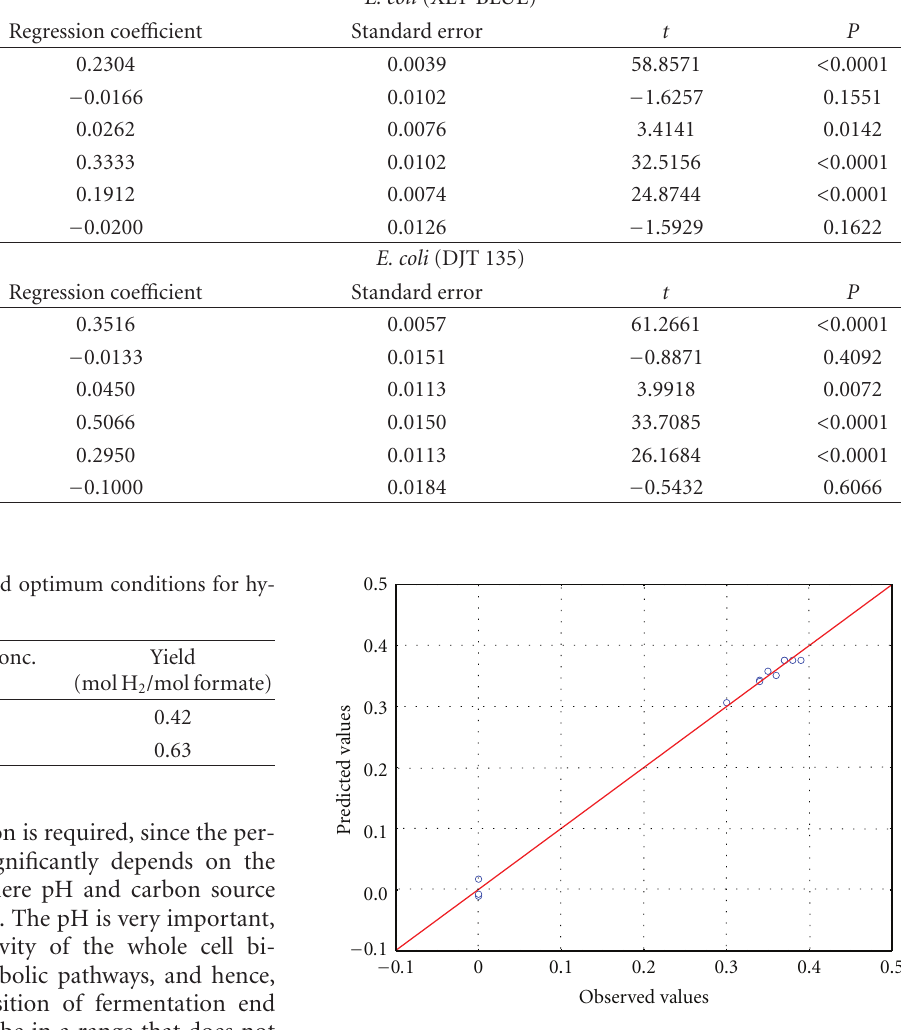
Figure 2: Parity plot showing the distribution of observed and predicted values of hydrogen yield for E. coli